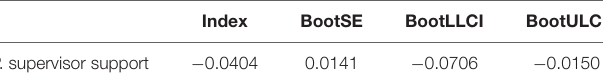
TABLE 6 | Bootstrapped results of moderated